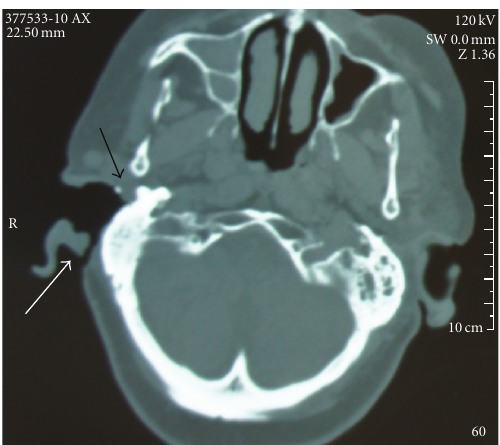
Figure 1: Axial high-resolution CT scan showing the retroauricular fistula (white arrow), sclerotic mastoid and granulation tissue in the middle ear area (black arrow).